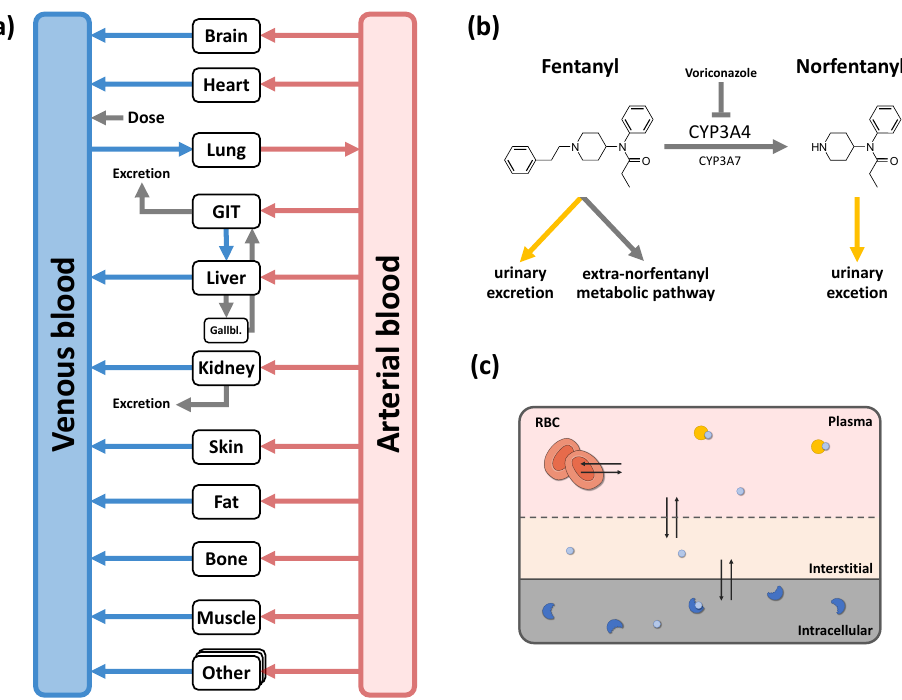
Figure 3. Structural overview of the whole-body physiologically-based pharmacokinetic (PBPK) model ( a ) and implemented elimination processes for fentanyl and norfentanyl ( b ). Each organ consists of a vascular space (containing plasma and red blood cells), interstitial space, and intracellular space. In ( a , c ), boxes indicate compartments, arrows denote in- / outflows, blue circles represent molecules, orange circles represent plasma proteins, and blue crescents denote enzymes. In ( b ), grey arrows indicate metabolic processes and yellow arrows indicate urinary excretion processes. CYP: cytochrome P450; GIT: gastrointestinal tract; Gallbl: